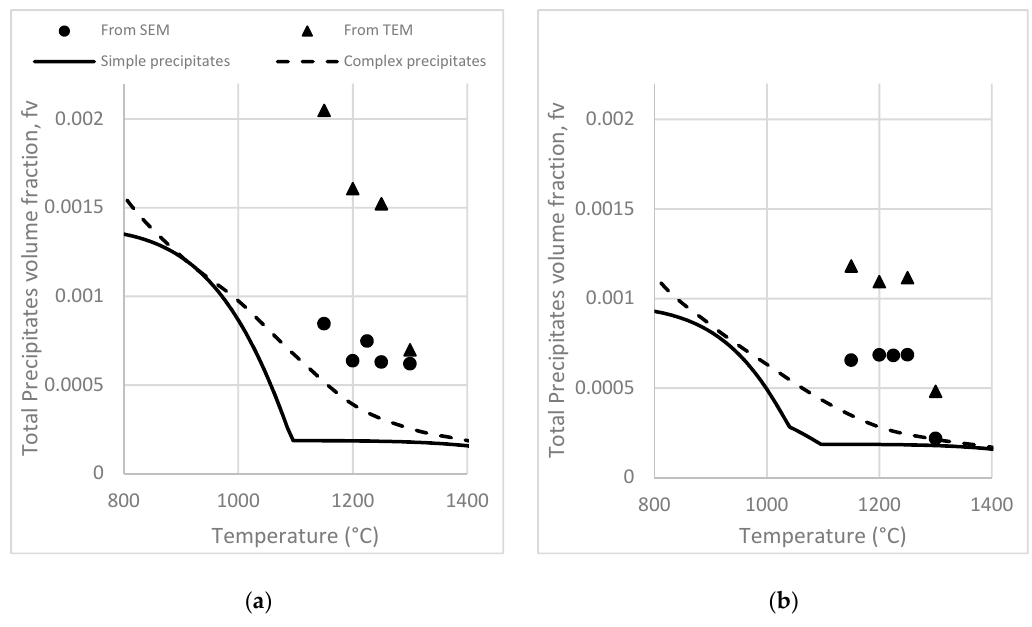
Figure 6. Experimental volume fraction of precipitates, compared to the calculated expectations: ( a ) high-Nb steel; ( b ) low-Nb steel.